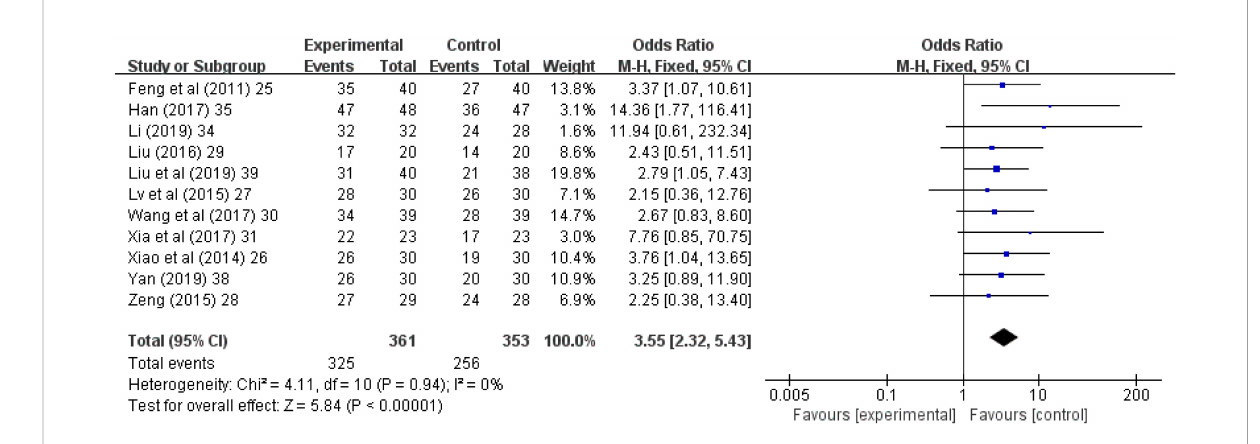
FIGURE 2 Forest chart of total effective rate after treatment. CI, Con fi dence Interval; M-H, Mantel Haenszel.